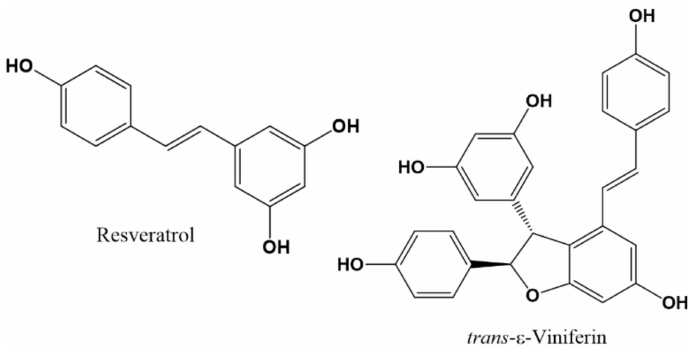
Figure 3. Chemical structures of active stilbenes on GABA A